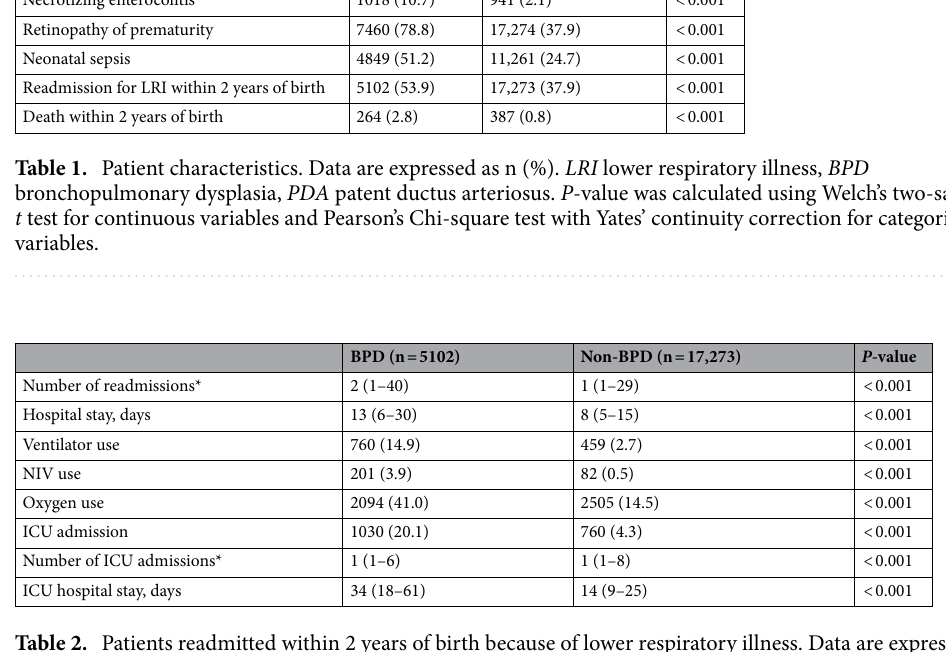
Table 2. Patients readmitted within 2 years of birth because of lower respiratory illness. Data are expressed as n (%), median (range)*, or median (interquartile range). The Mann–Whitney U test was used for non-normal distributions in continuous variables. BPD bronchopulmonary dysplasia, NIV non-invasive ventilator, ICU intensive care